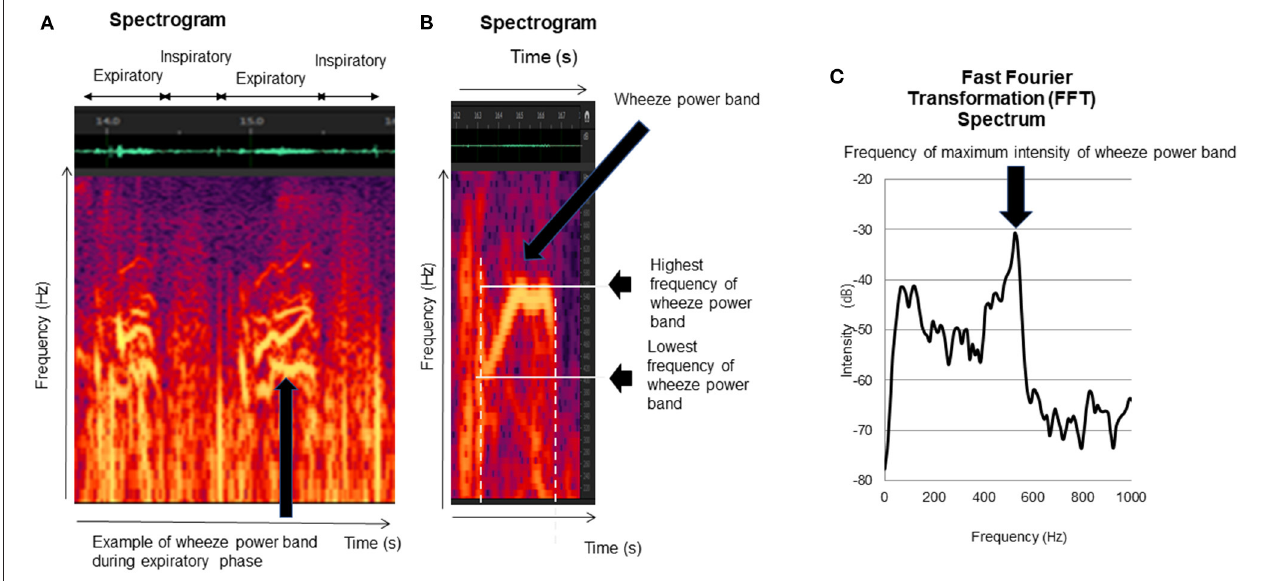
FIGURE 2 | Wheezing indexes. The lung sound analysis displayed wheezes as horizontal bars of intensity with corresponding sharp peaks of power. The sharp peak of power was defined as a wheeze. The following indexes were calculated: (1) duration of wheeze power bands (B) , (2) number of wheeze bands per 30s (B) , (3) lowest frequency of wheeze power bands (B) , (4) highest frequency of wheeze power bands (B) , and (5) frequency of maximum intensity of wheeze power bands (C) .